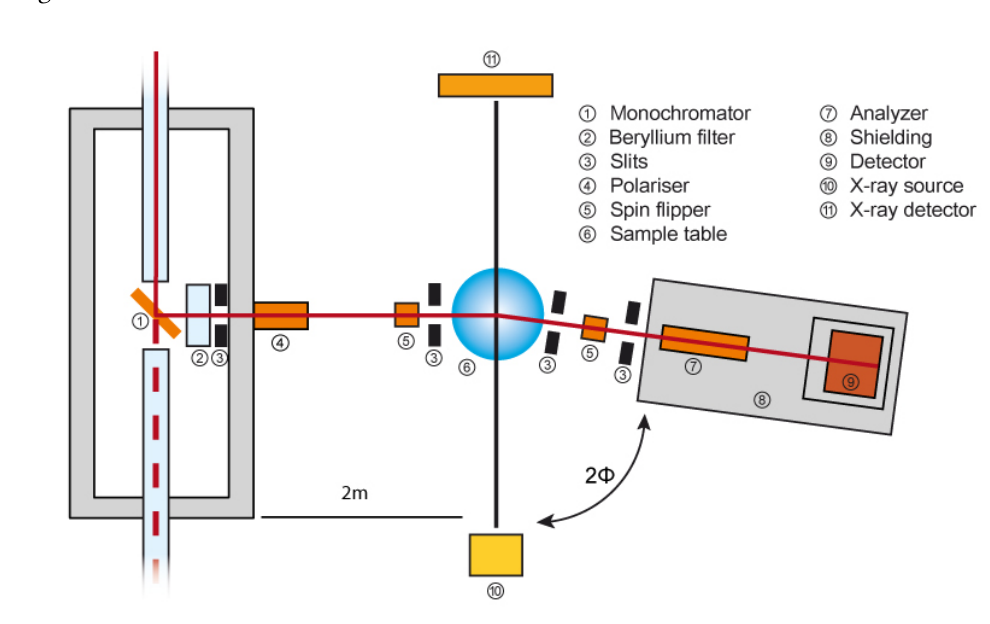
Figure 2: Schematic drawing of